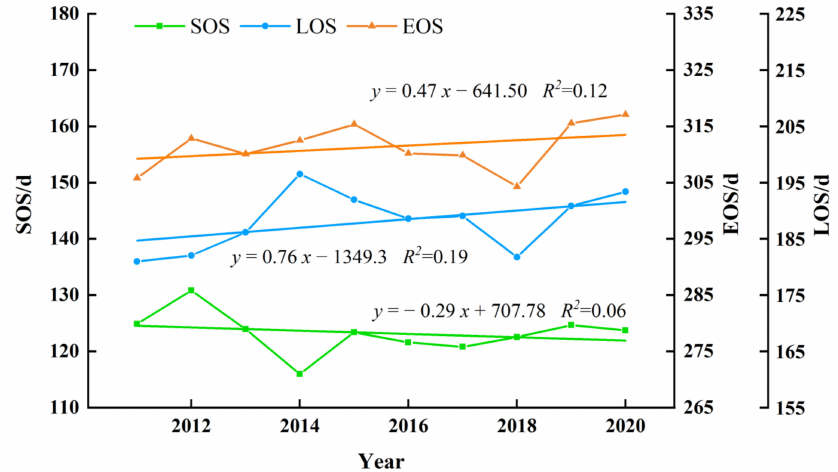
Figure 10. Interannual changes of forest phenology in northeast China from 2011 to